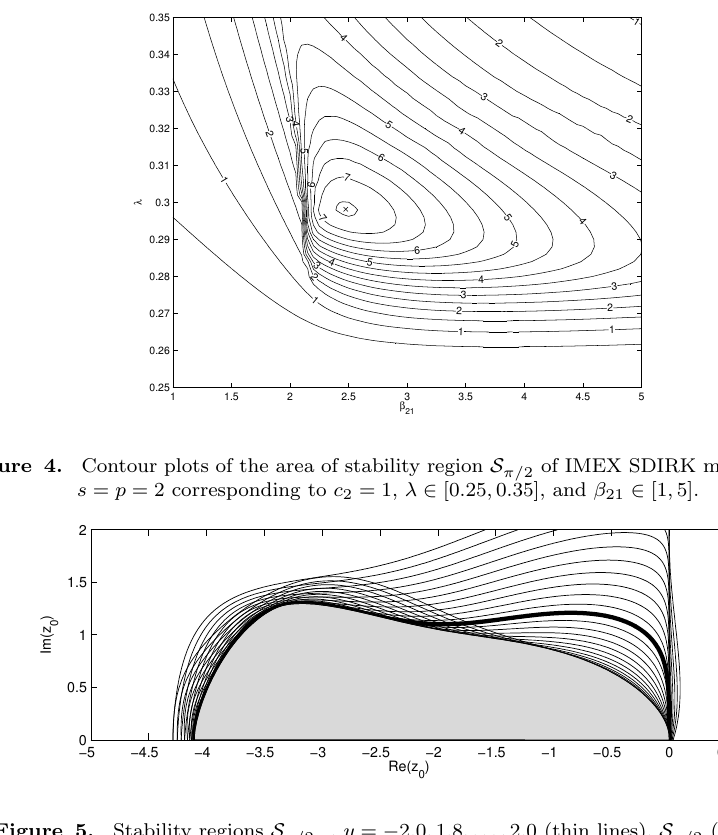
Figure 5. Stability regions S π/ 2 ,y , y = − 2 . 0 , 1 . 8 ,..., 2 . 0 (thin lines), S π/ 2 (shaded region), and S E (thick line) for λ ≈ 0 . 30, , c 2 = 1 and β 21 ≈ 2 .